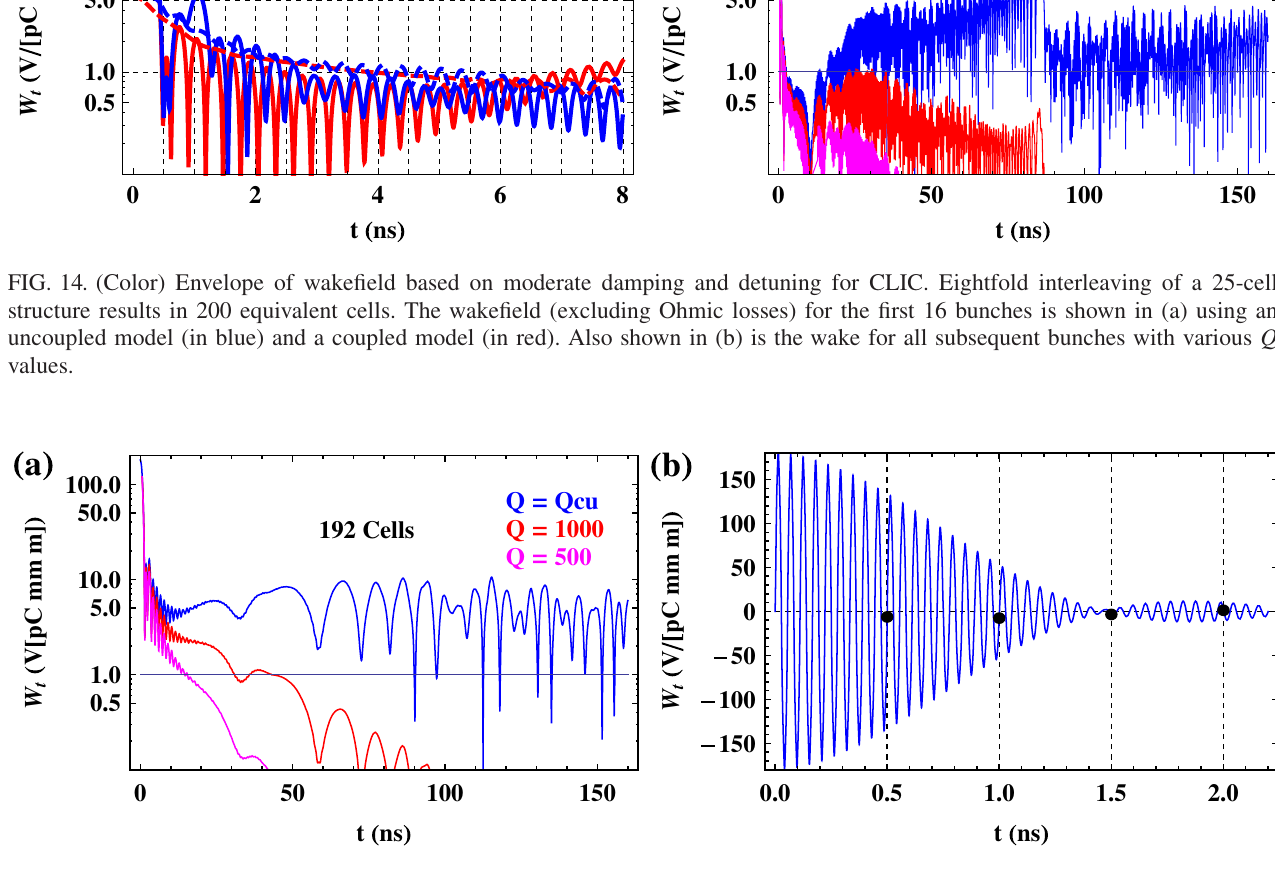
FIG. 15. (Color) Envelope of wakefield based on moderate damping and detuning for CLIC. Eightfold interleaving of a 24-cell structure results in 196 equivalent cells. The envelope of the wakefield for various Q values is shown in (a) and the amplitude of the wakefield is shown in (b), demonstrating the bunches are located at the zero-crossing points in the wake.